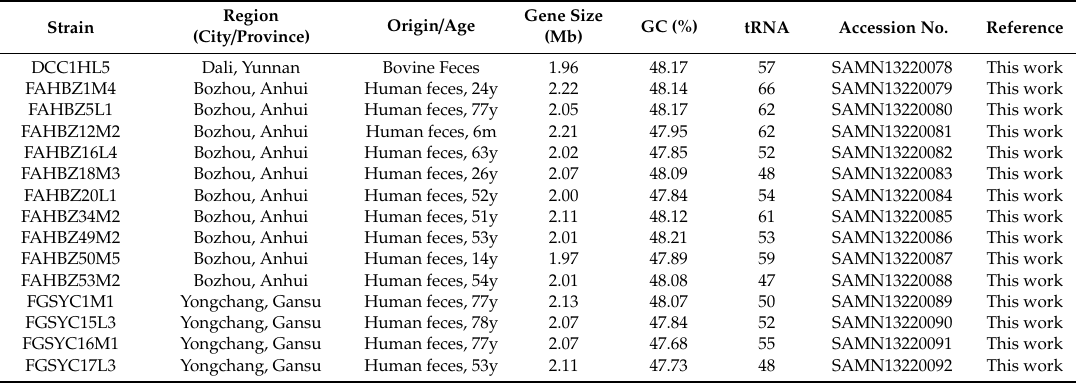
Table 1. Host information and general genome features of 101 strains of L. mucosae.